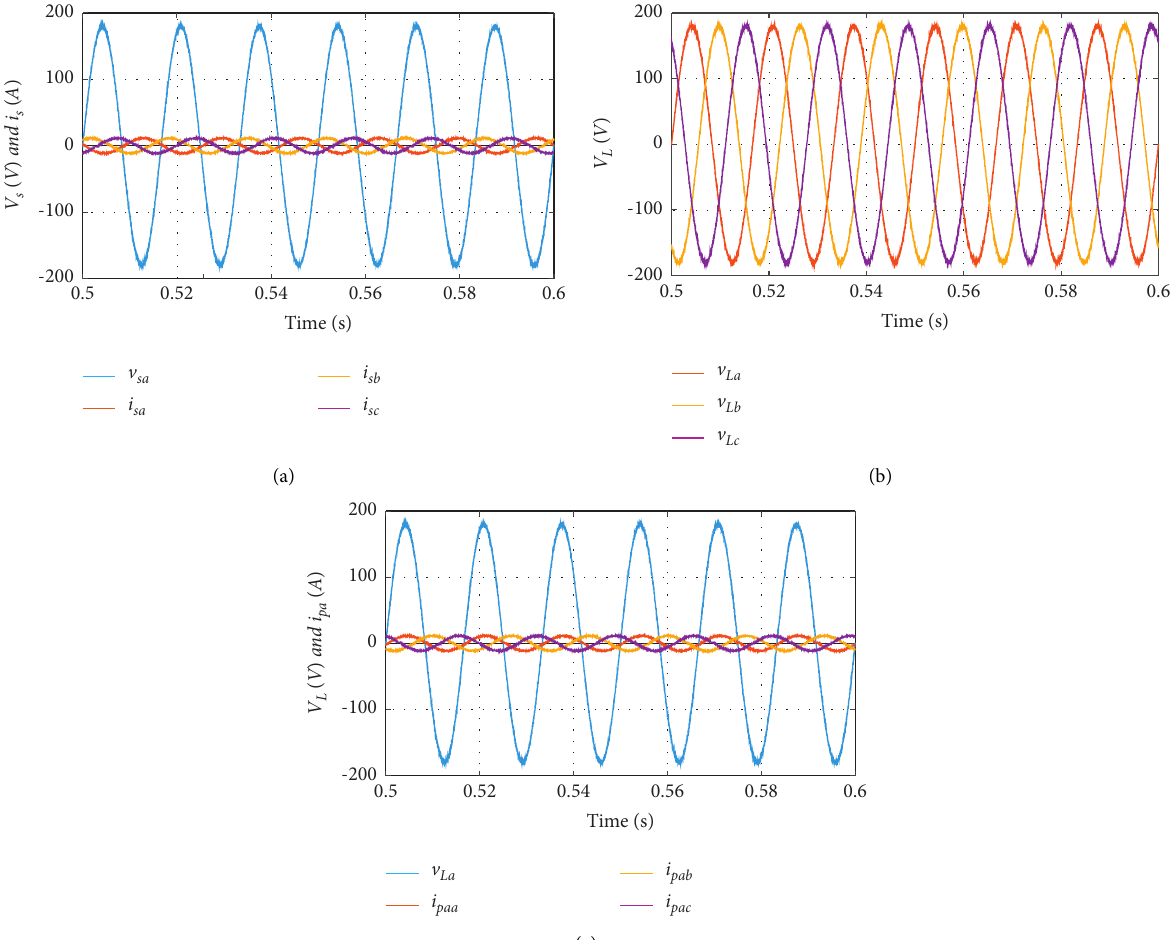
Figure 5: Only active power interjection is performing by Wind-PV-UPQC into the grid with P voltage currents, (b) load voltages, (c) load voltage and parallel converter currents.